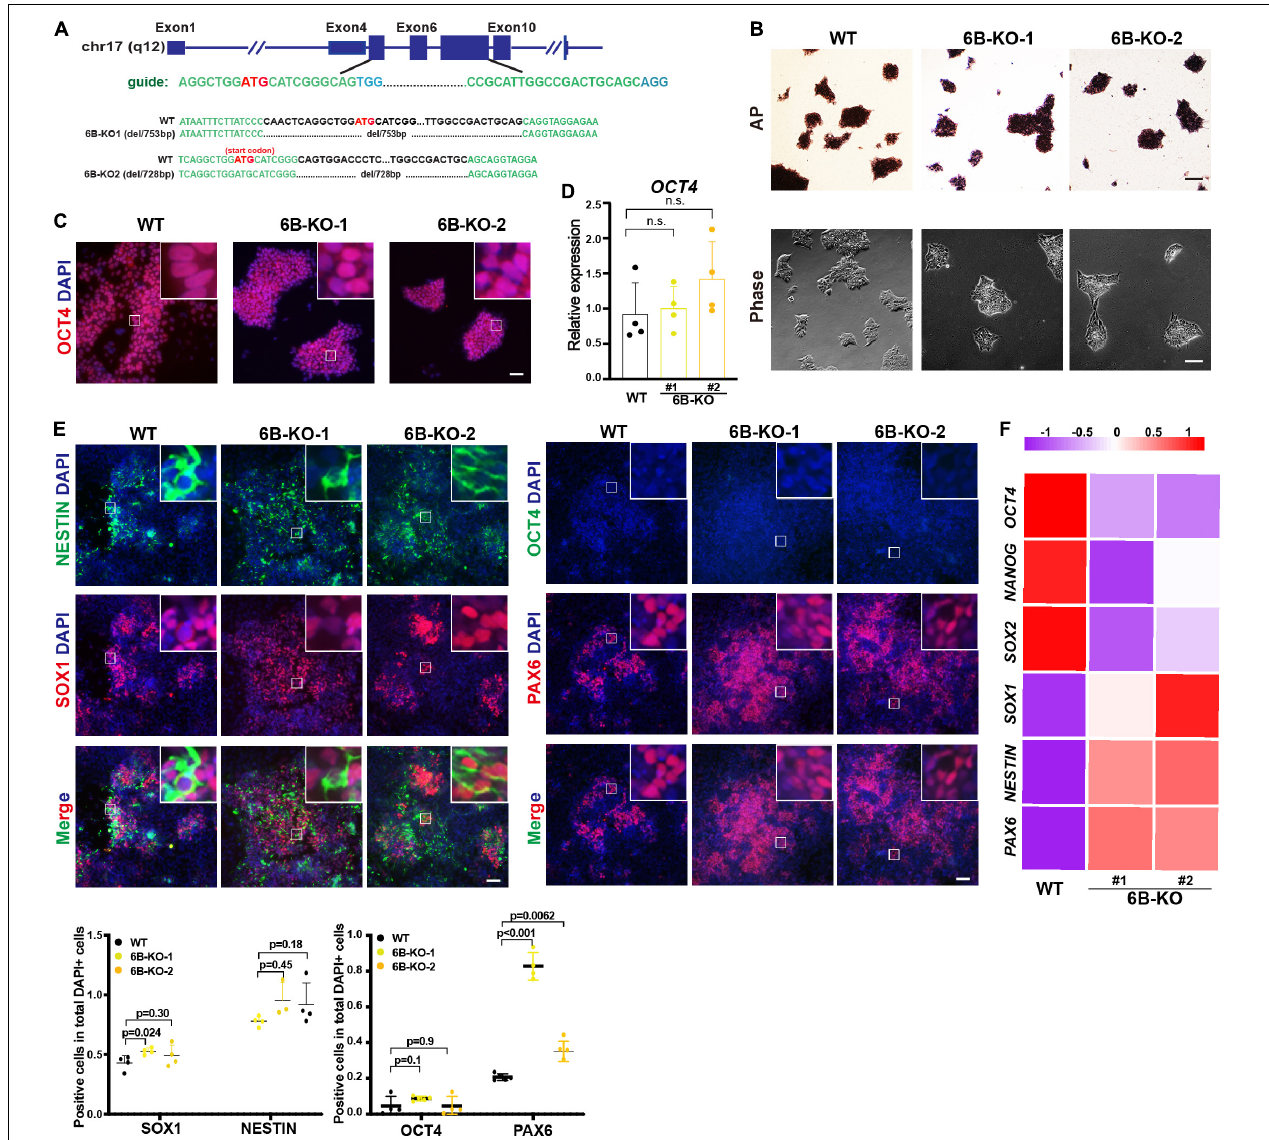
FIGURE 2 | KDM6B knockout enhanced neuroectoderm differentiation. (A) Illustration of KDM6B locus, sgRNA sequences, and generated mutations. (B) Morphology and AP staining of KDM6B-KO cells and wild-type ESCs. Scale bar = 100 µ m. (C,D) The immunofluorescence staining (C) and RT-qPCR analysis (D) of the pluripotent marker OCT4 in the KDM6B-KO cells at undifferentiated ESC states. Scale bar = 50 µ m. (E,F) The immunofluorescence staining images (up) and quantification (down) (E) and RNA analysis (F) of pluripotent or neural markers in the KDM6B-KO cells after 7 days of neuroectoderm differentiation. Scale bar = 50 µ